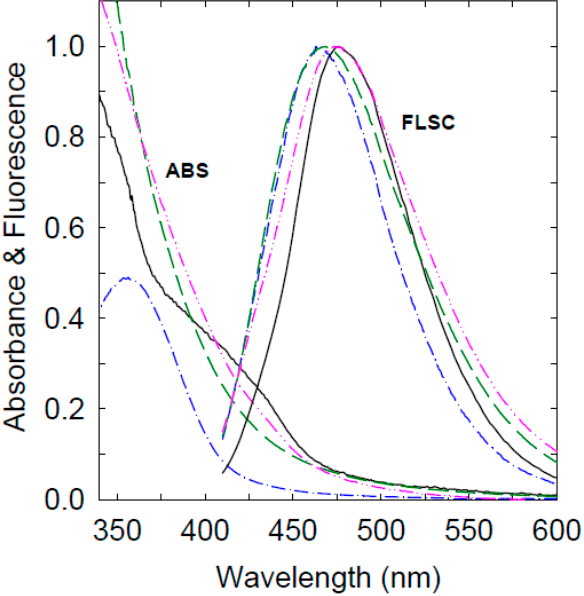
Figure 2. Optical absorption (ABS) and fluorescence (FLSC, 400 nm excitation) spectra of CS200 (dash-dot line), CS330 (solid line), CS MT (dash-dot-dot line), and PEI-CDots (dash line), all in aqueous solutions.